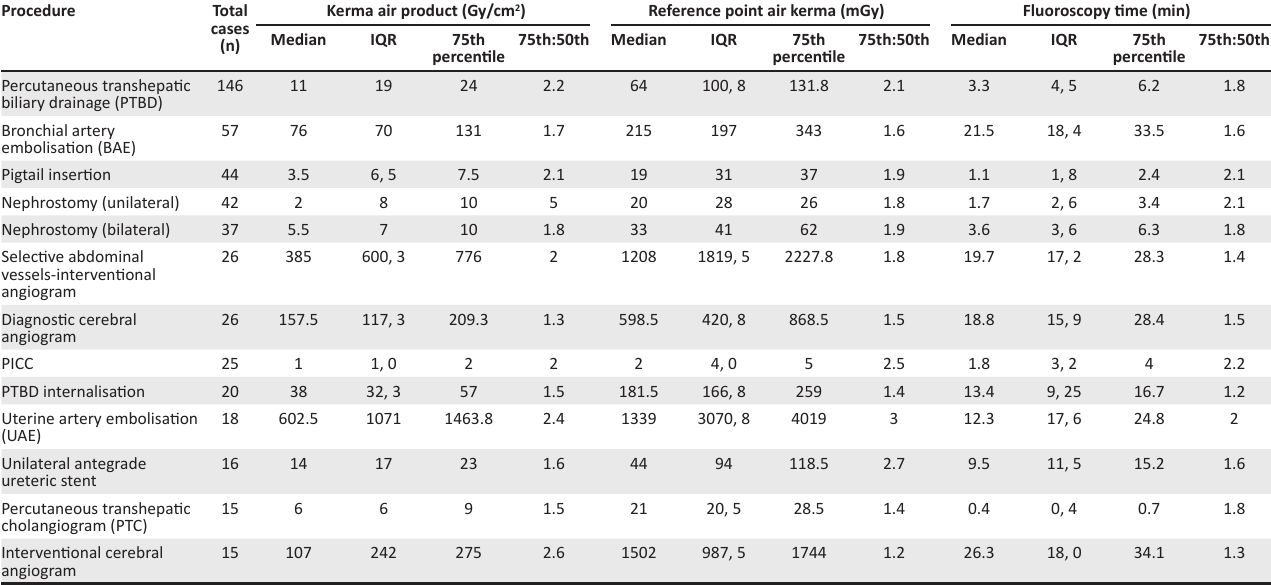
FIGURE 1: The total number of interventional radiology cases performed during the study period was 564. The 13 most frequent procedures (each with 15 or more cases) representing 86.1 % ( n = 487) of all cases are reflected. TABLE 1: Dosimetry data for Chris Hani Baragwanath Academic